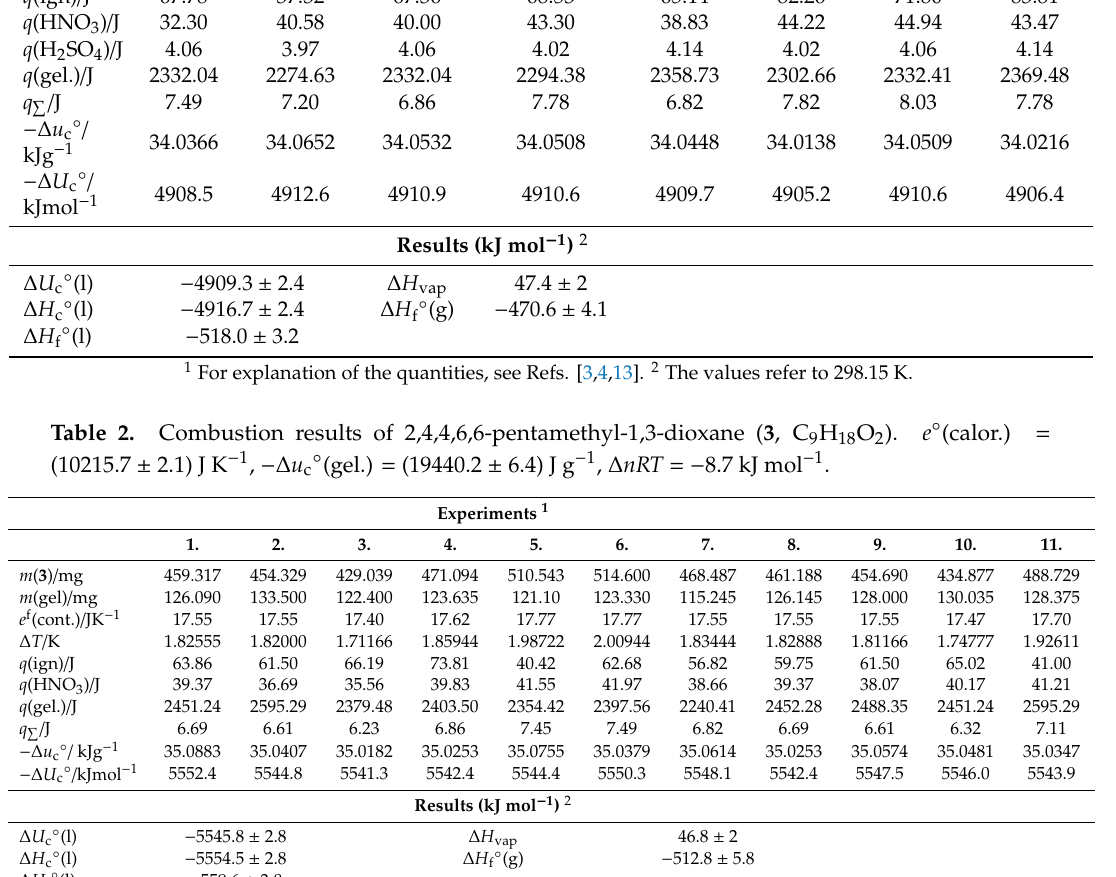
Results of the combustions of 2,2,4,4,6-pentamethyl-1,3-dioxane ( 4 , C 9 H 18 O 2 ). ρ ( 4 ) = 0.9240 g cm − 3 , ε (calor.) = 2261.6 ± 0.7 J Ω − 1 , c